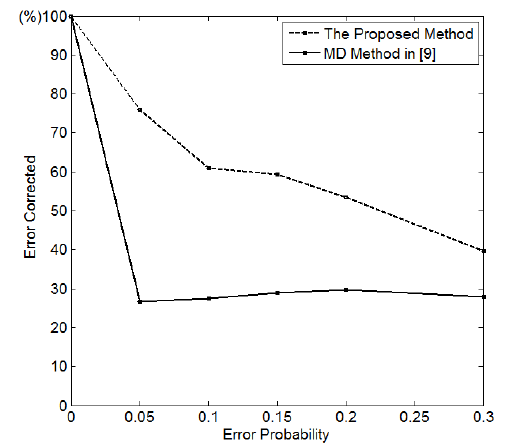
Figure 5. Comparison of Proposed Method and The Method in [9] On Probability of Errors Corrected.